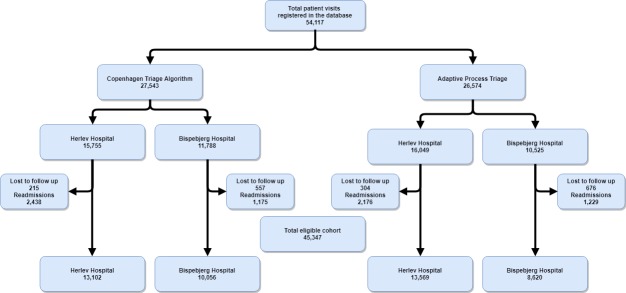
CONSORT diagram.